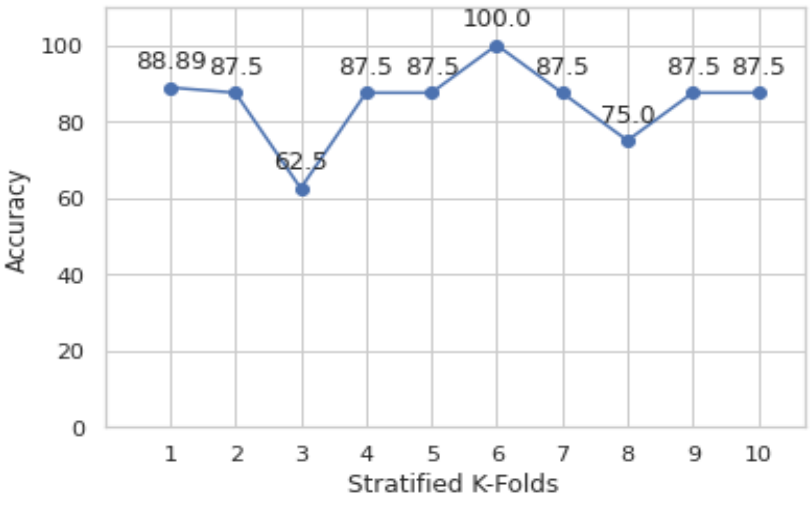
Figure 9. The classification accuracies of the SVM model using the ten-fold stratified cross-validation. The classification accuracy of the KNN model using stratified five-fold cross-validation is shown in Figure 10. It demonstrates that folds 3 and 5 have the most remarkable accuracy. This model supported the stratified 5-fold cross-validation with a mean accuracy of 85.22% and an SD of 0.0740. After Hyperparameter tuning using stratified 5-fold cross-validation, the optimal parameters were determined at n_Neighbor = 9 and p = 2.